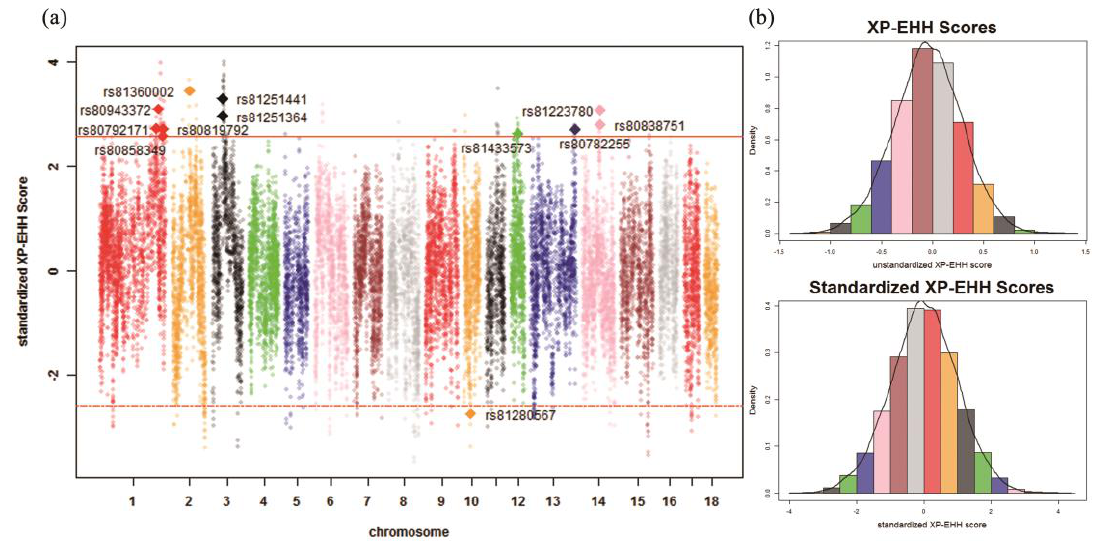
Figure 4. XP-EHH scores across all autosomes in the Ding’an and Tunchang/Saba group s. ( a ) Genome-wide distribution of signatures of selection detected by XP-EHH across all autosomes in the Ding’an and Tunchang/Saba group s. The SNPs shown as diamonds are the significant SNPs detected simultaneously by two methods. The red lines show the threshold P -value (0.01). ( b ) The distribution of unstandardized XP-EHH scores and standardized XP-EHH scores across all autosomes in the Ding’an and Tunchang/Saba group s.